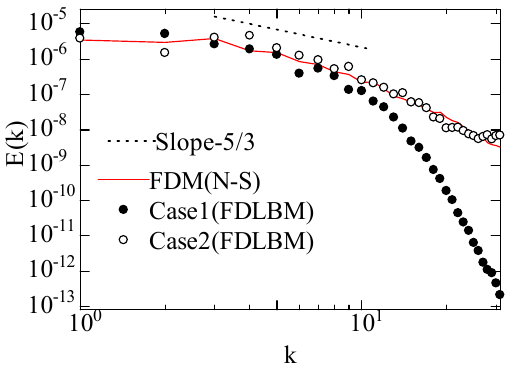
Fig. 2 Energy spectra with the S Model (time step = 10000).